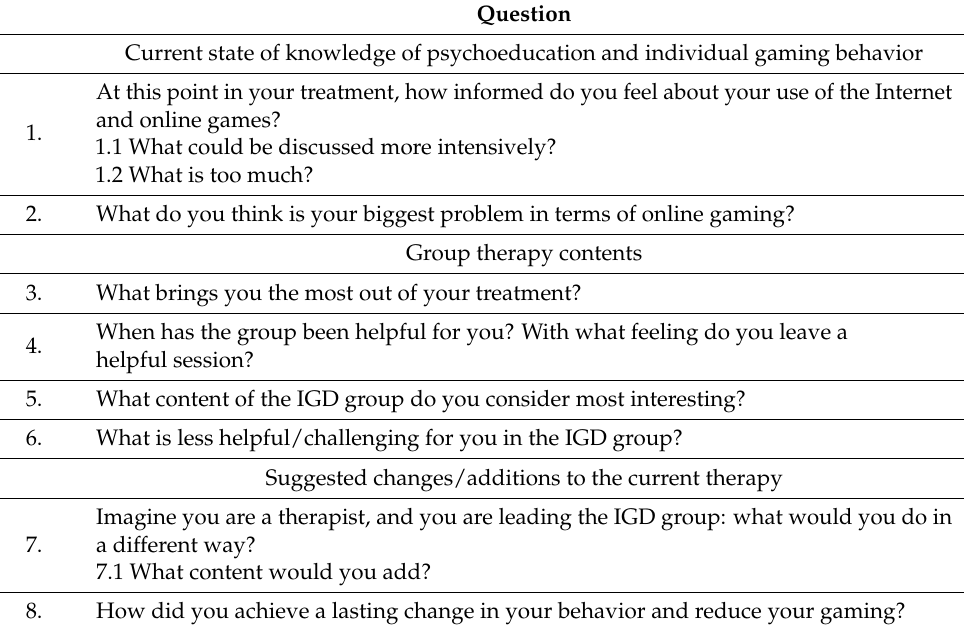
Table A1. Patient interview guide (translation by the